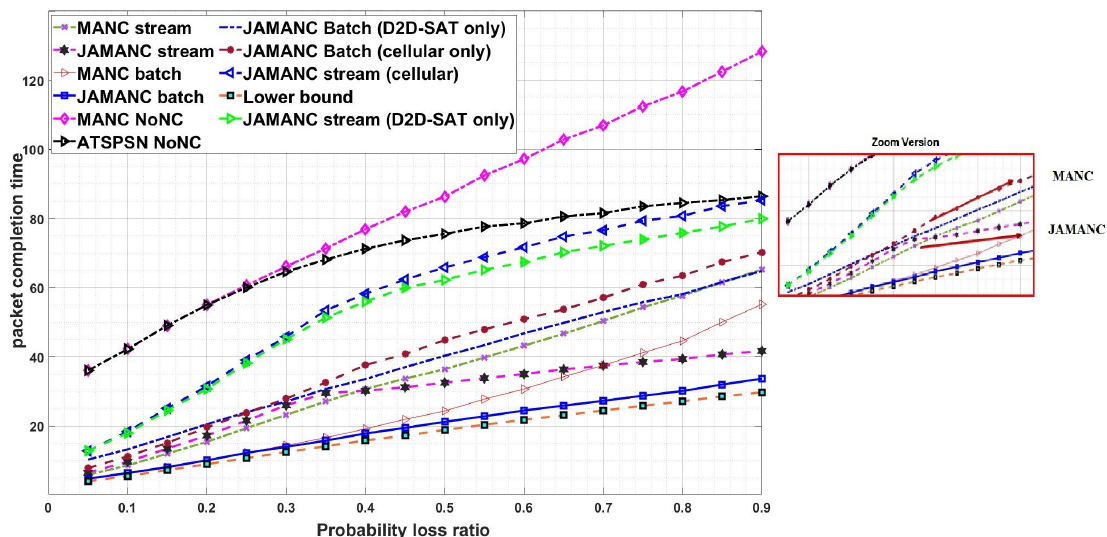
Figure 14. Packet Completion time versus probability loss